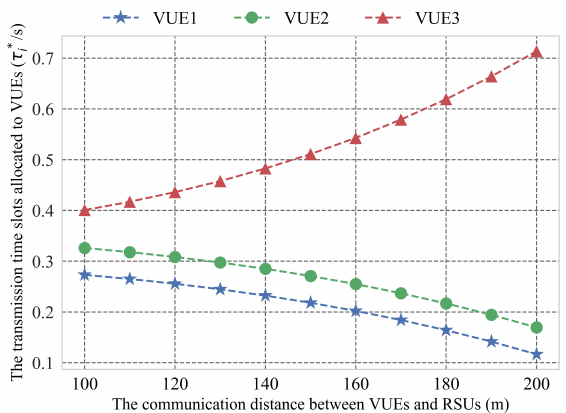
Figure 6. The time fraction allocation of VUEs when VUE3 moves away from the RSU.